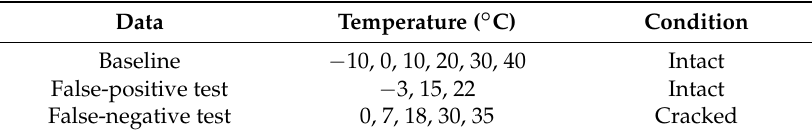
Figure 8. Self-sensing nonlinear ultrasonic system for temperature variation tests. AWG: arbitrary waveform generator; DIG: 14-bit digitizer. Table 3. Test scenarios under temperature variation.